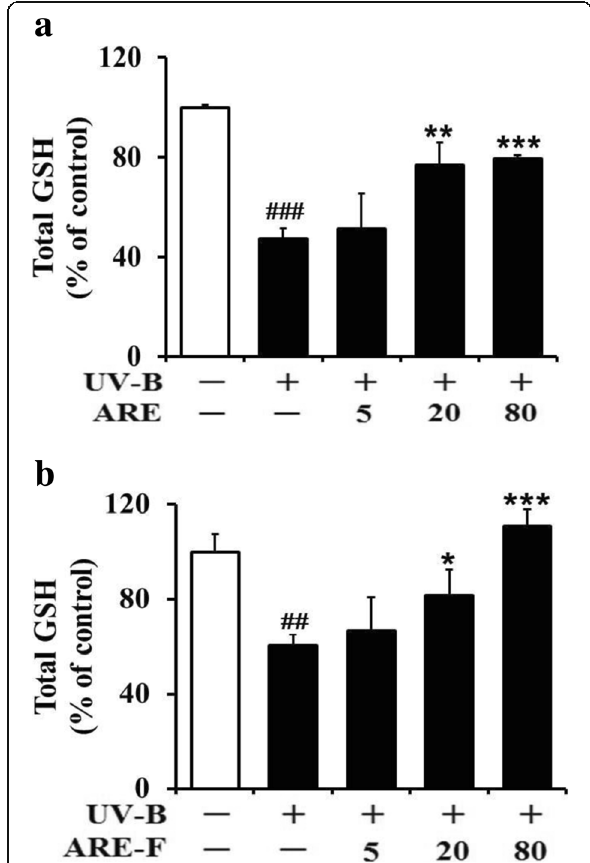
Fig. 4 Enhancing effects of ARE ( a ) and ARE-F ( b ) on the total GSH attenuation in HaCaT keratinocytes under UV-B irradiation. HaCaT cells were subjected to the varying concentrations (0, 5, 20 and 80 μ g/mL) of ARE ( a ) and ARE-F ( b ) for 1 h before the irradiation. The total GSH content in the cellular lysates, quantitated with an enzymatic recycling assay using GR, was expressed as a percentage (%) of the corresponding non-irradiated control. ## P < 0.01; ### P < 0.001 versus the non-irradiated control. * P < 0.05; ** P < 0.01; *** P < 0.001 versus the non-treated control (UV-B irradiation